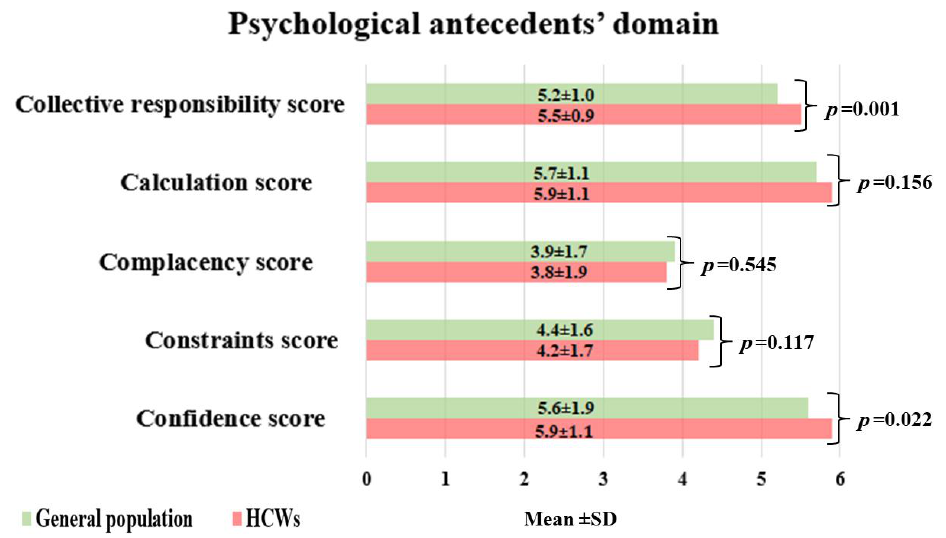
Figure 1. The psychological antecedents of the general population versus HCWs.